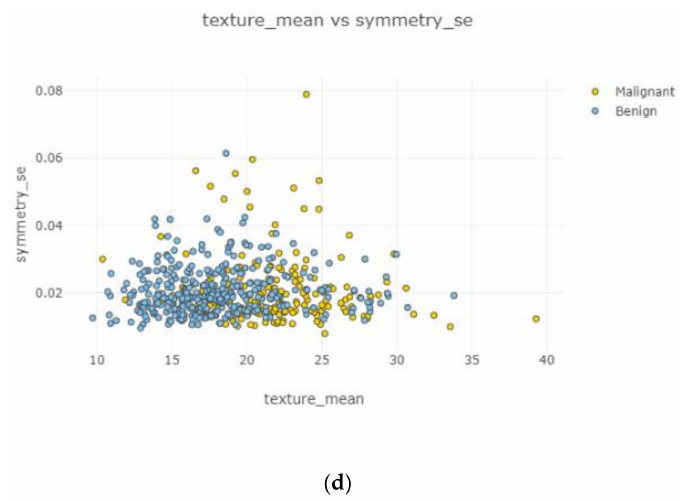
Figure 11. Uncorrelated scatter plots 1–4.